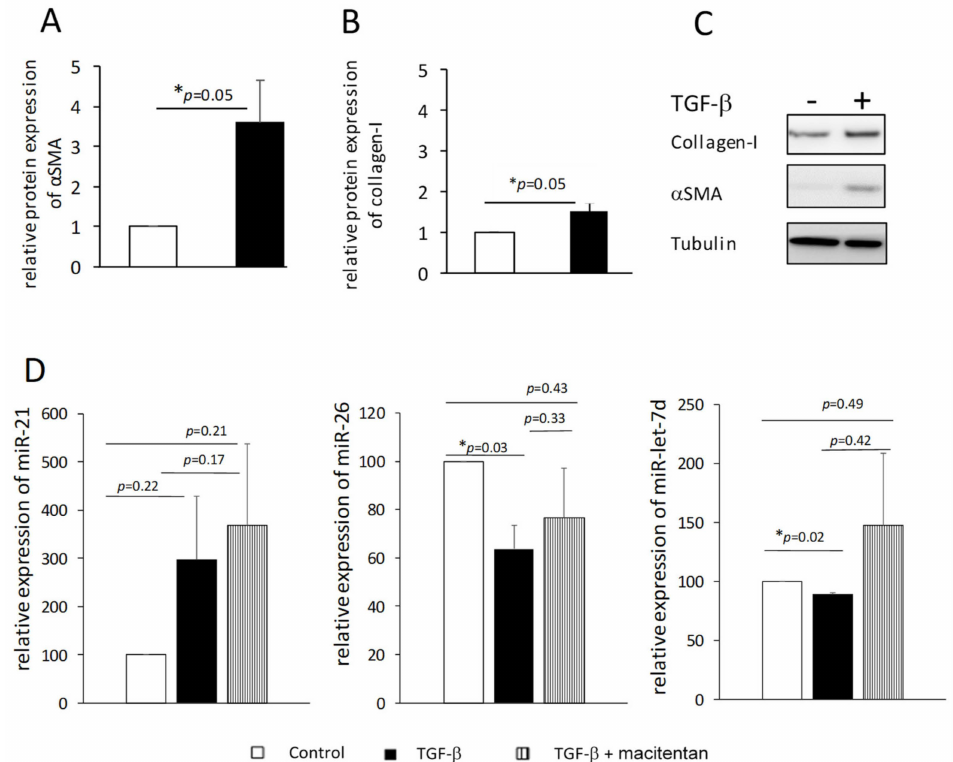
Figure 4. TGF- β induced myofibroblast differentiation is accompanied by reduced miR-26 and miR-let-7d levels. Dermal fibroblasts were isolated from healthy patients undergoing plastic surgery. The cells were exposed to TGF- β (10 ng/mL) for 48 h or 72 h. Then the cells were either harvested and counted (72 h) or harvested and their proteins and RNA isolated (48 h). The levels of the myofibroblast markers α SMA ( A ) and collagen I ( B ) were assessed by western blot, and the levels of miR-21, miR-26 and miR-let-7d were assessed with qRT-PCR ( D ). ( C ) is a representative blot of α SMA and collagen in cells that were treated or not treated with TGF- β ( n = 4). Columns represent mean and whiskers represent standard errors. *—Statistically significant results, p ≤